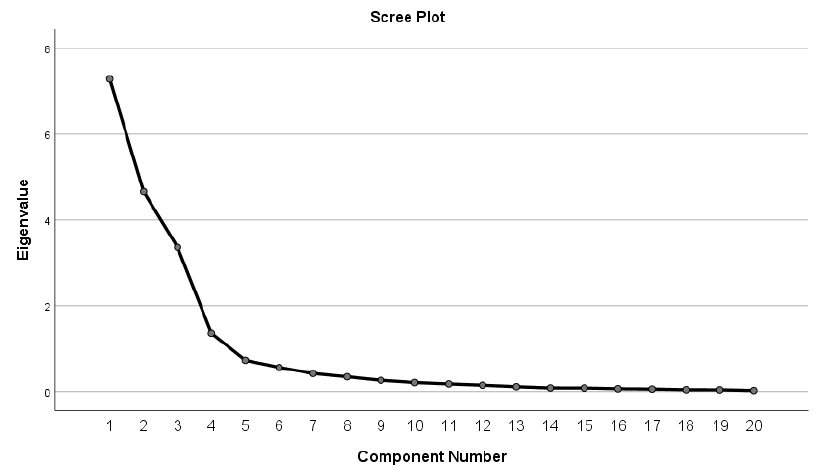
Figure 1. Scree plot for factor analysis.